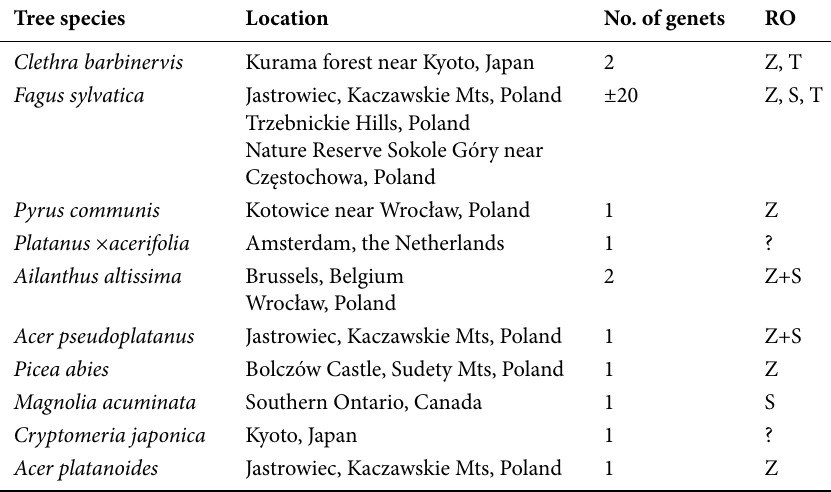
Table 1 Cases of radial waviness recorded in a